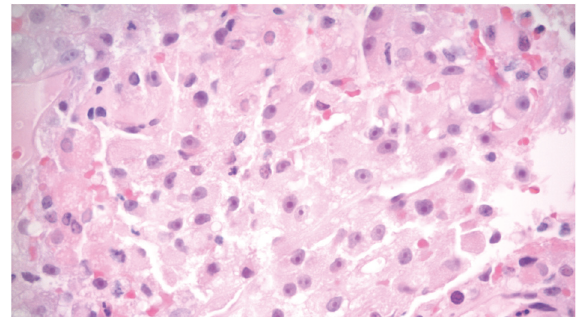
Figure 6:Vaginalmass biopsy: demonstrating positive reactivityfor immunohistochemical CD10 Stain, consistent with